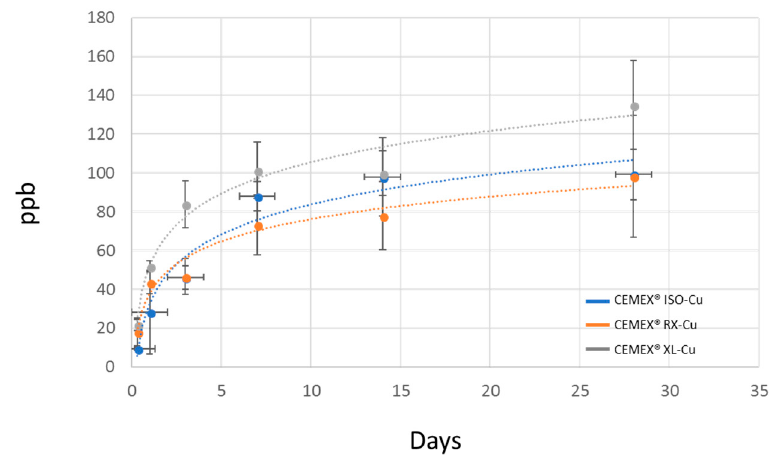
Figure 7. Copper release trend and amount for composite bone cements.